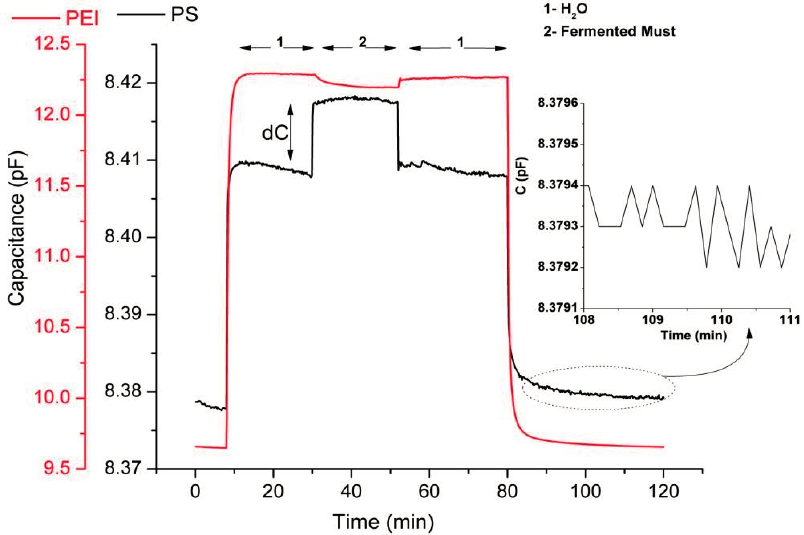
Figure 5. Typical example of dynamic responses of two sensors of the sensor array upon exposure to reference and fermented must. (Sample of fermented must: Must 1 fermentation process-Day 6). Also zoom in PS-coated sensor response is shown (insert graph).